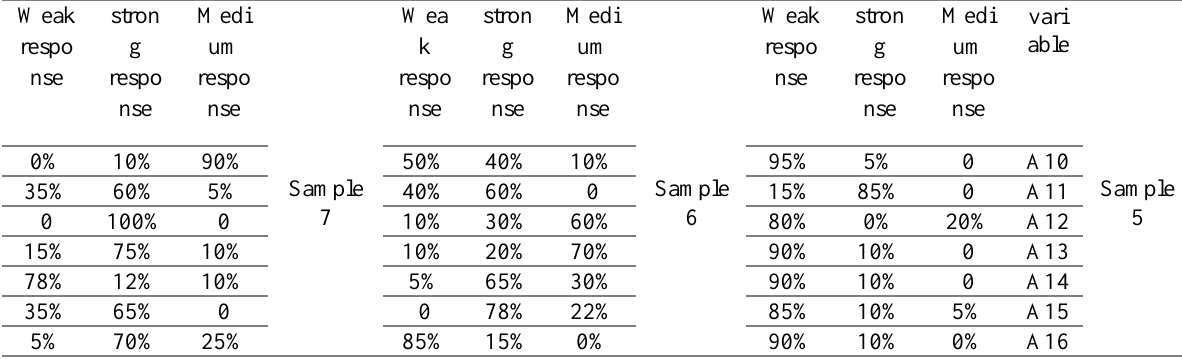
Table 3. The disparity and agreement between the samples 5, 6 and 7 about the values of the coordinated